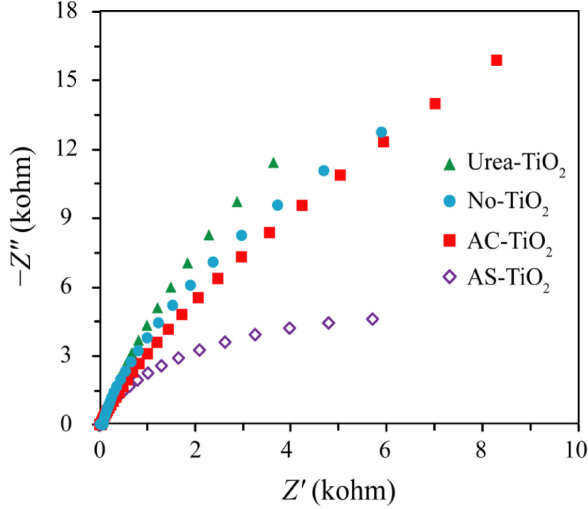
Figure 6. Electrochemical impedance spectroscopy Nyquist plots of AC-TiO 2 , AS-TiO 2 , urea-TiO 2 , and No-TiO 2 electrodes in 0.2 M Na 2 SO 4 aqueous solution.